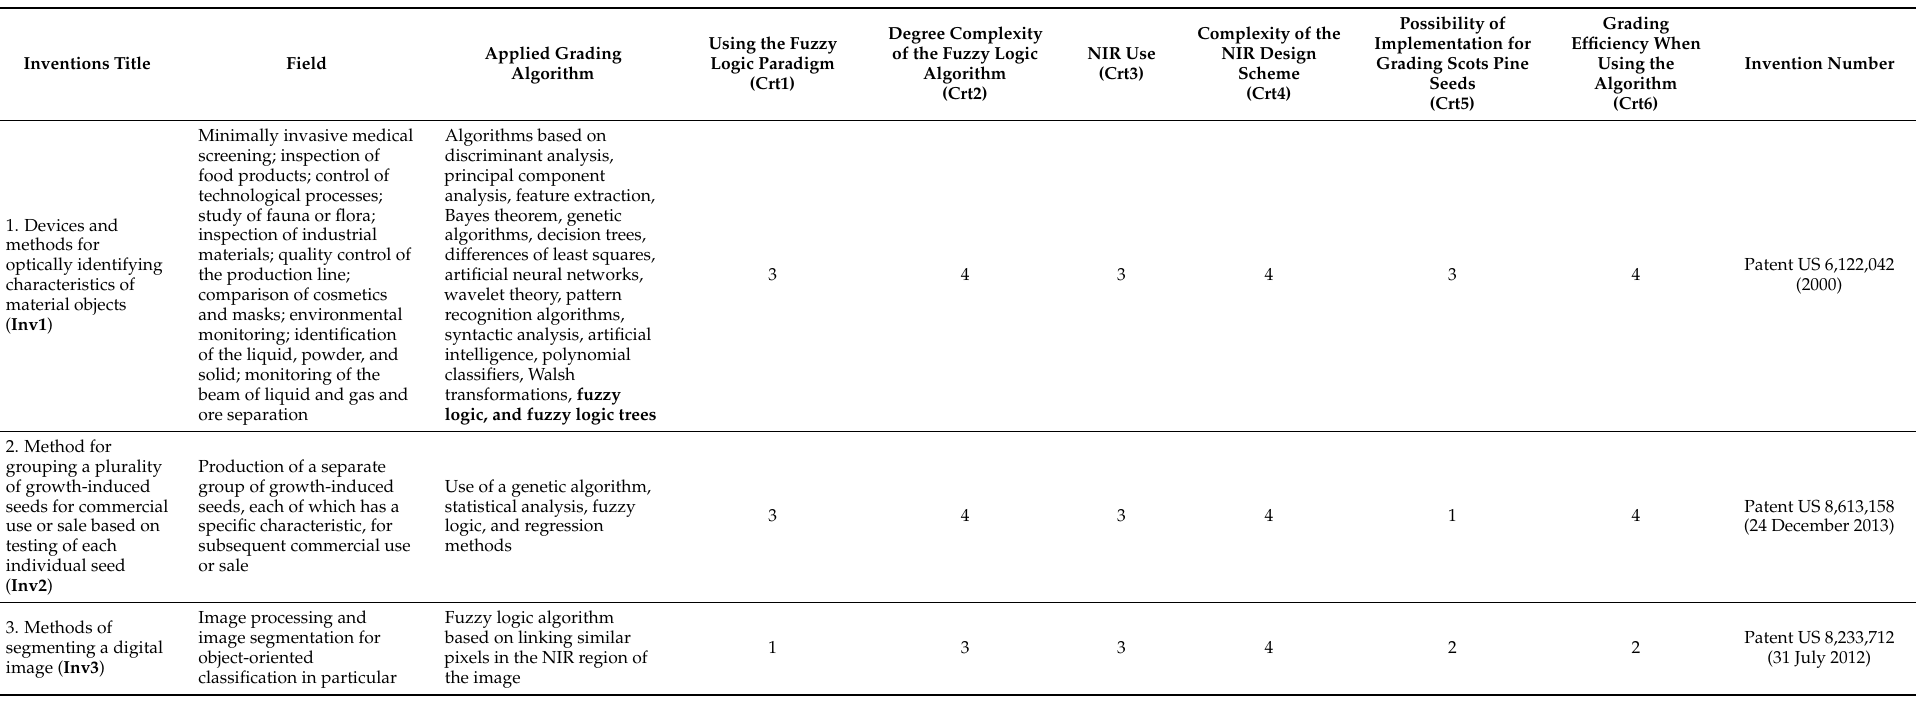
Table A1. The degree of evaluation was encoded using rank variables as follows: 1—high; 2—medium; 3—low; and 4—zero (or no description, data). A Scopus request [TITLE-ABS-KEY (NIR AND “fuzzy logic” AND seed AND (sort? OR grad? OR separate?))] was